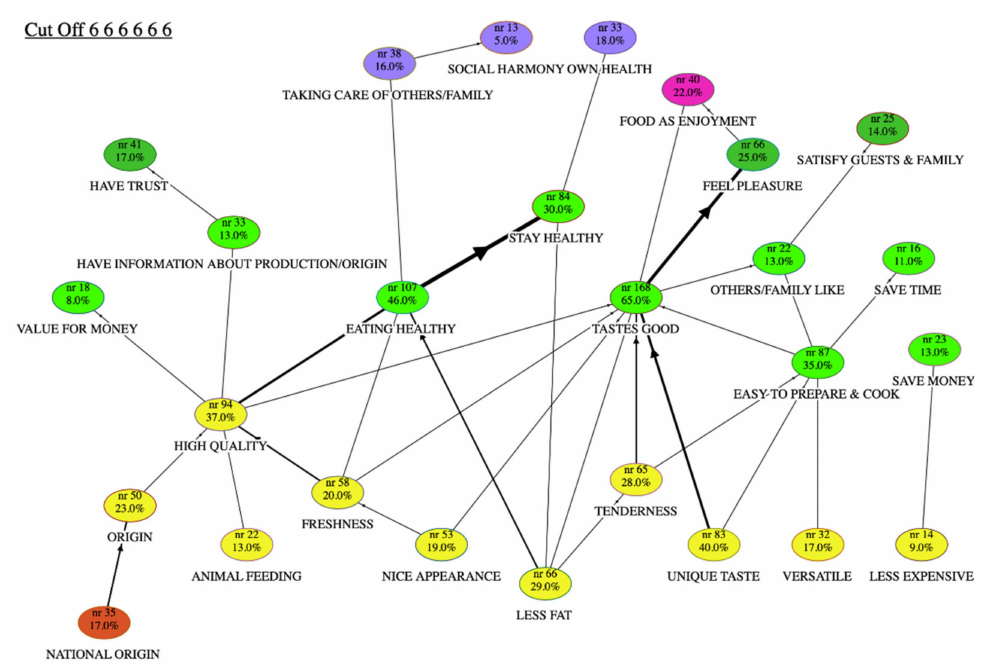
Figure 1. Hierarchical value map of sheep and goat meat consumers. For each node, the name and the number of answers are given in the content code, and the percentage of participants who named